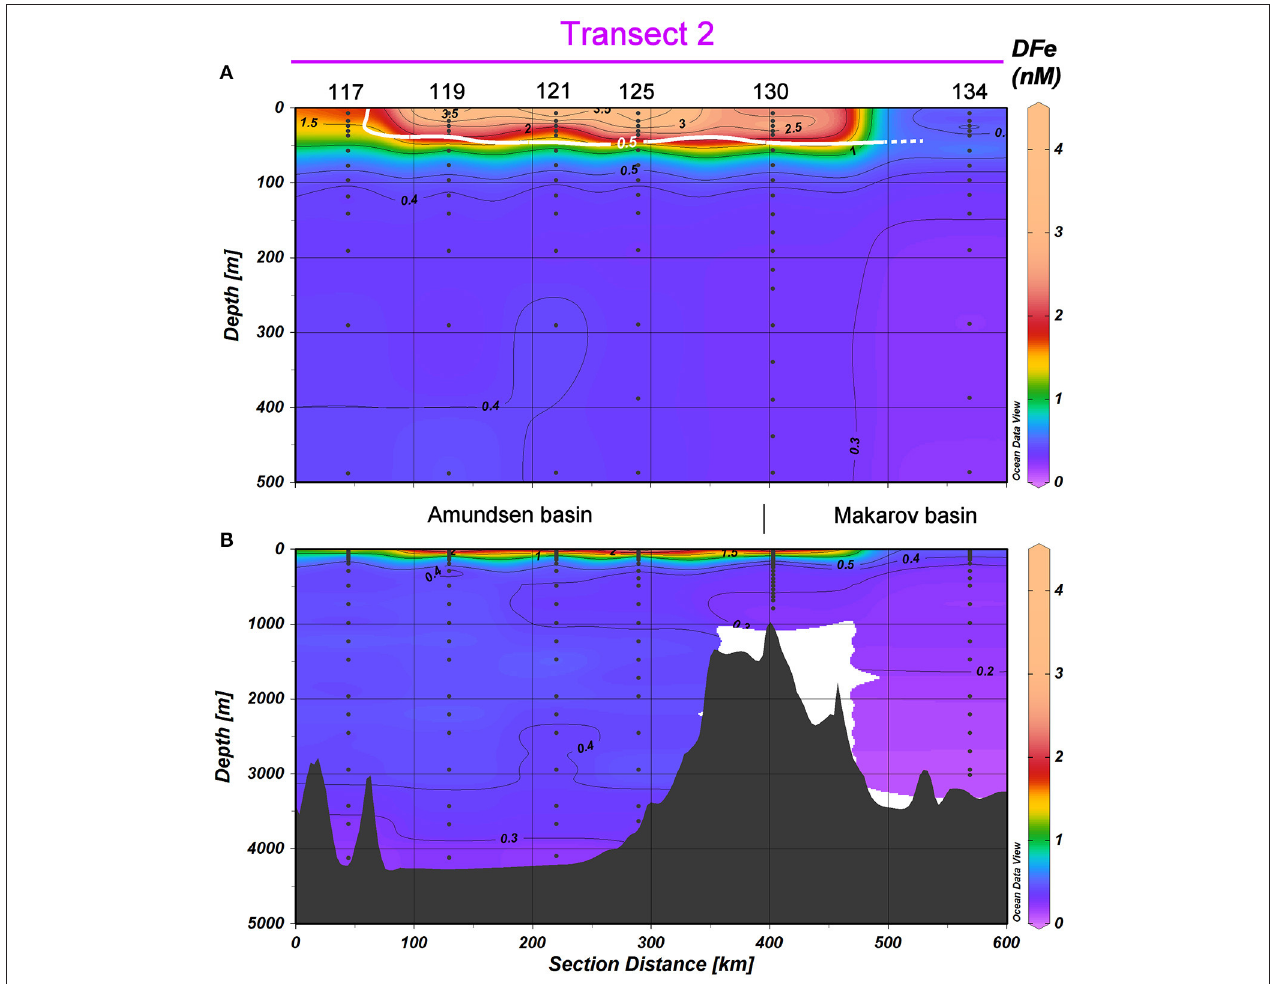
FIGURE 6 | DFe in nM in Transect 2, with (A) the top 500m and (B) the full depth. Station numbers and basin names are given (see Figure 1 ). The white contours indicate the border of the TransPolar Drift as defined by Slagter et al. (2017), which was operationally defined as in-situ CDOM fluorescence ≥ 0.5a.u. during the same cruise. Black contours indicate DFe and have an equidistance of 0.1nM for the range 0 ≤ DFe ≤ 0.5nM and of 0.5nM for the range 0.5 < DFe ≤